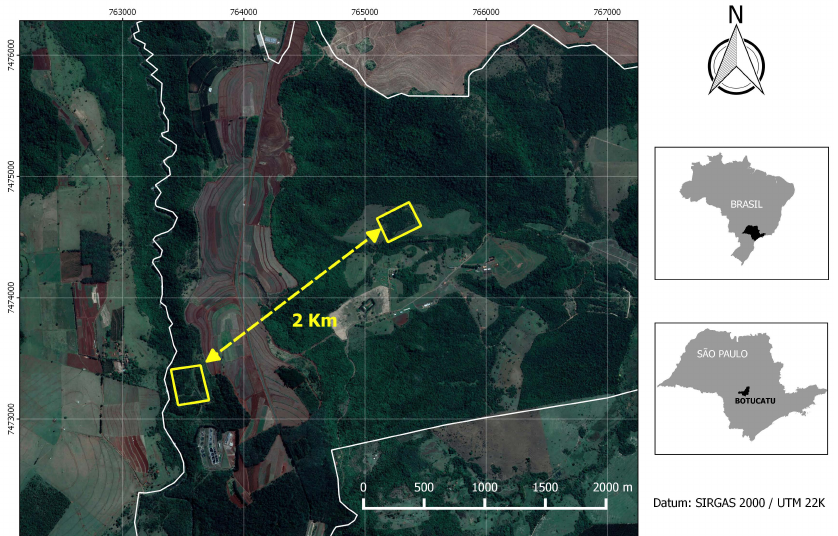
Figure 1. Aerial view of the study area in the state of S ã o Paulo, Brazil, showing the two experimental sites: Ultisol (U) left side and Alfisol (A) right side.